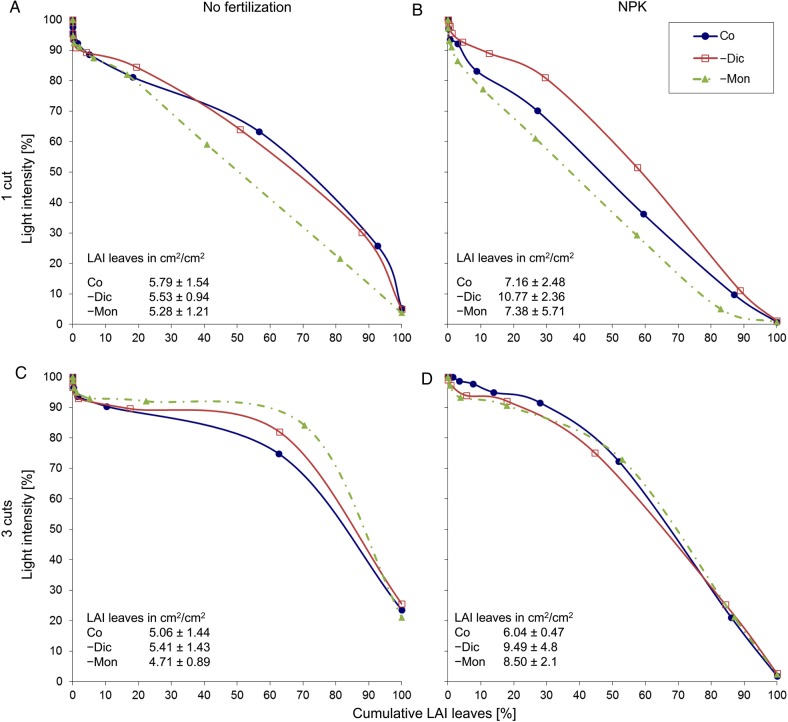
Means of LAI (leaves) and light intensity in relation to cumulative LAI (leaves) in the experimental treatments in July 2009 grouped by management regime (A = 1x, B = 1NPK, C = 3x, D = 3NPK). The sloping curves show the light intensity from above the canopy (0 % LAI) in 10 cm steps down to the ground (100 % LAI), n = 6.